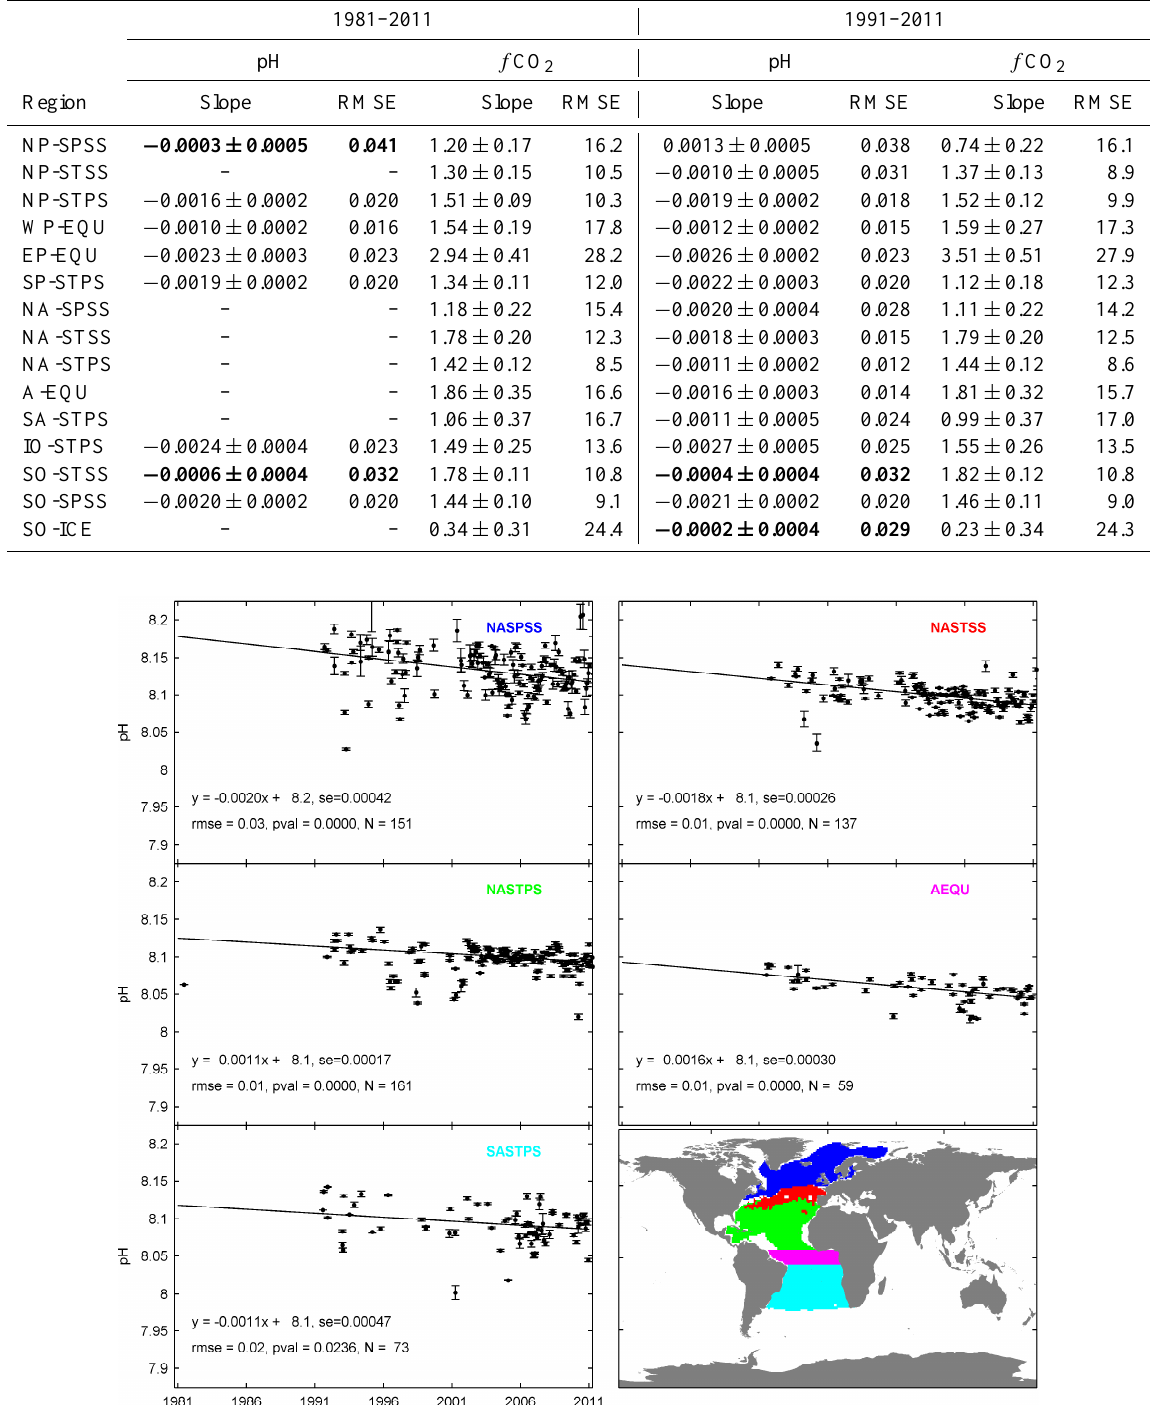
Table 1. Results and statistics of the regression analysis of f CO 2 (µatm) and pH insitu versus time. Bold text indicates biomes where the results are not statistically significant (95% confidence). No number is given if a biome does not have enough data to calculate the trend in a given time period.